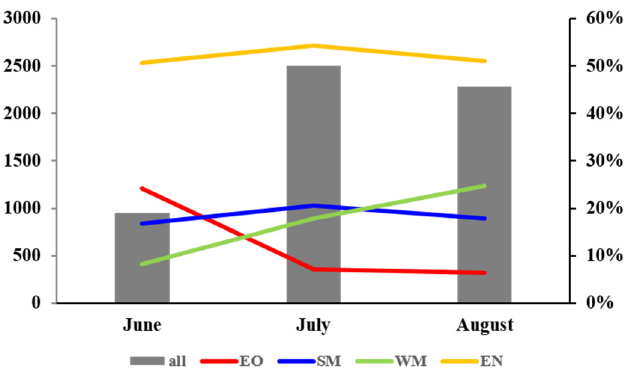
Figure 9. Monthly variation of MCS number (gray columns) and proportion of EOs (red), SMs (blue), WMs (green) and ENs (yellow) from 2013 to 2019.